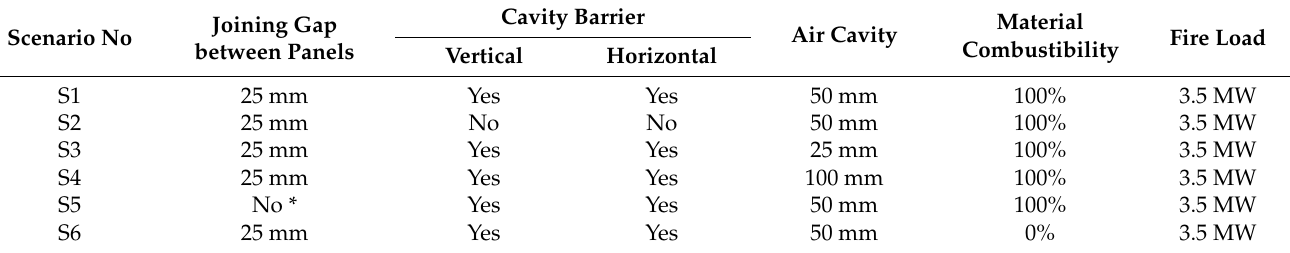
Table 3. Numerical simulation scenarios and parametric configurations.